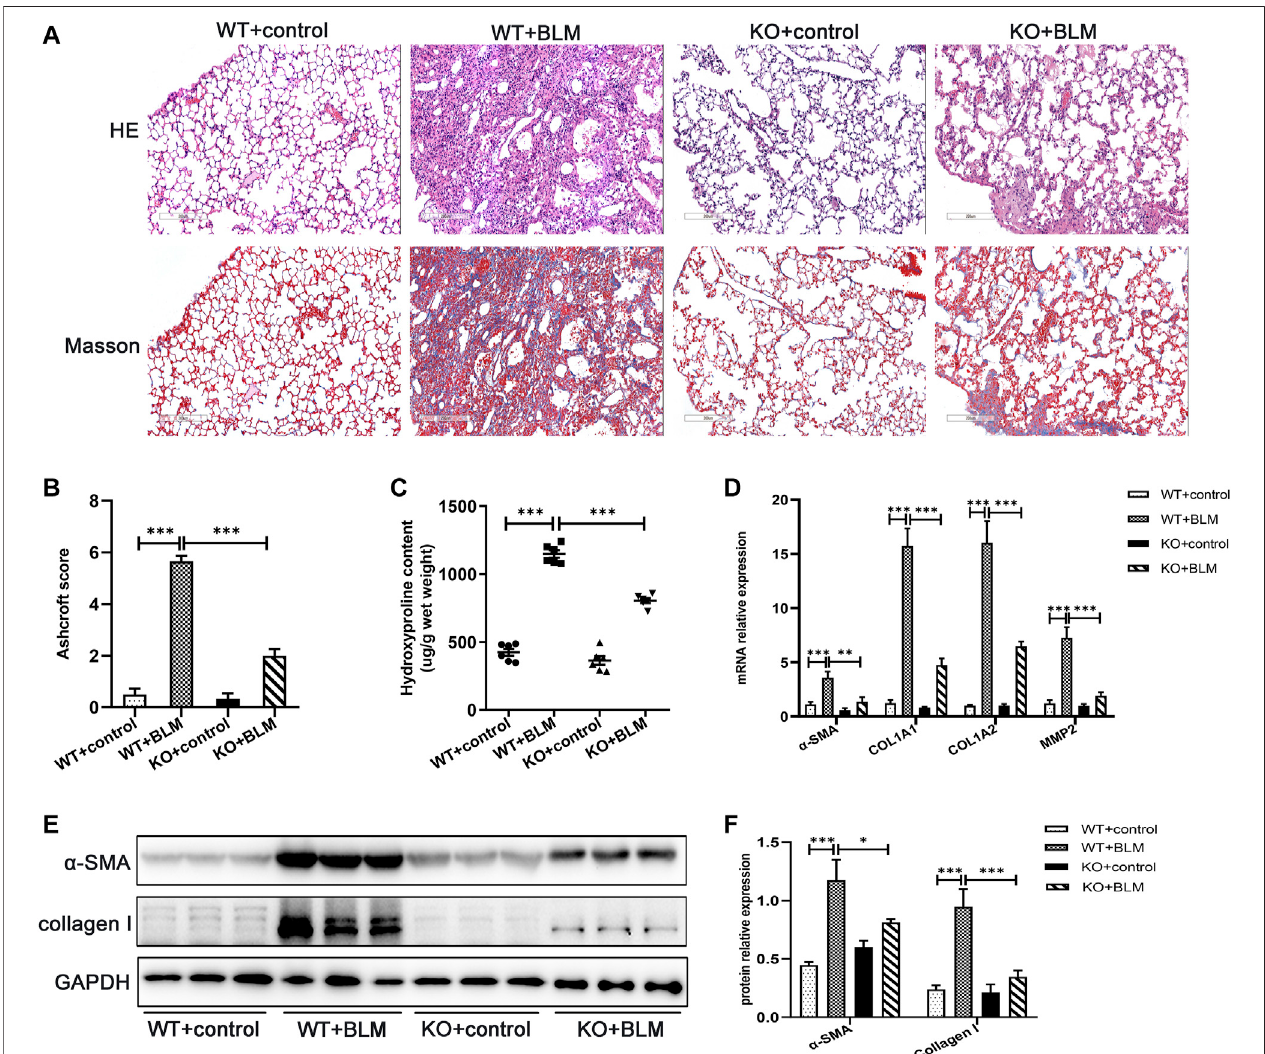
FIGURE 2 | Dec1 KO ameliorates BLM-induced PF in mice. WT and KO mice were treated with a single intratracheal injection of BLM (2.5 mg/kg) or saline for 21 days. (A) Representative HE staining and Masson ’ s trichrome staining of lung tissues in mice. Scale bar = 200 μ m. (B) Ashcroft score was measured using the Ashcroft method. (C) Total collagen levels were assessed by measuring hydroxyproline content in the lung tissues of mice. (D) The mRNA expression of α -SMA, COL1A1,COL1A and MMP2 inthelungtissuesofmiceweremeasuredbyqRT-PCR. (E) Theproteinexpressionof α -SMAandcollagenIinthelungtissuesofmice weredetectedby western blotting. (F) Statistical analysis ofrelative expression levels ofproteins inE. n = 6.Dataare shown as themean ± SEM. Statistical analysiswas performed by one-way ANOVA. * p < 0.05, ** p < 0.01, *** p < 0.001, ns p > 0.05.